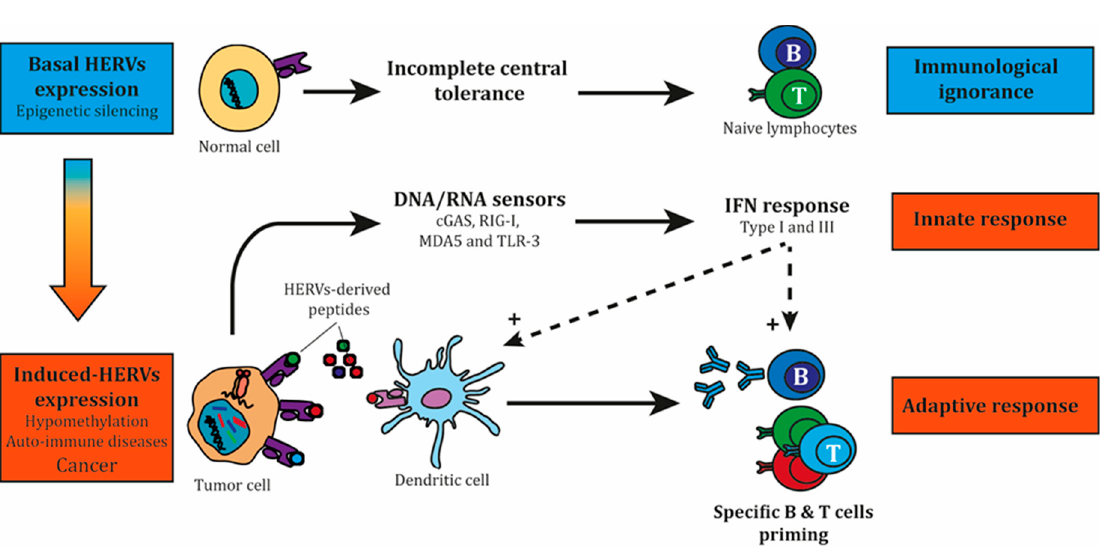
Figure 2. HERVs as relevant and unique targets for cancer immunotherapy. At steady state, most HERVs are not expressed, mainly silenced by epigenetic mechanisms. Basal HERV expression can be found in some tissues and in the thymus, with an incomplete central tolerance. Di ff erent circumstances such as auto-immune diseases or cancer can foster HERVs expression, leading to the production of both HERVs-derived nucleic acids and proteins. These intermediates can promote an innate immune response by inducing type I and III IFN production through DNA / RNA sensors, and also an adaptive immune response through B and T cell epitopes. IFN: Interferon.